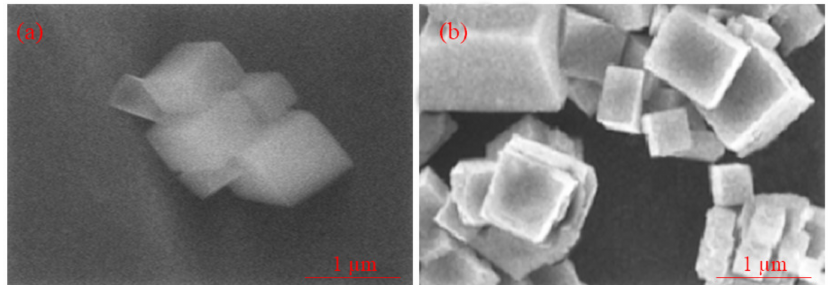
Figure 4. FE-SEM images of NH 2 -MIL-253 (Al) MOF ( a ), and Tb@NH 2 -MIL-253 (Al) MOF ( b ) fluorescence